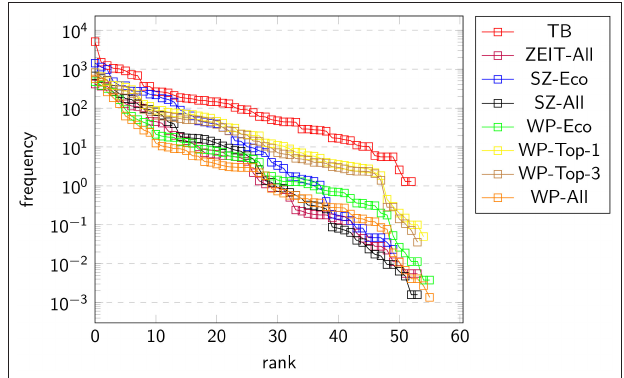
FIGURE 2 | Rank-specificity distribution of threshold concepts based on lemma (sentence-specificity) and compounding frequencies